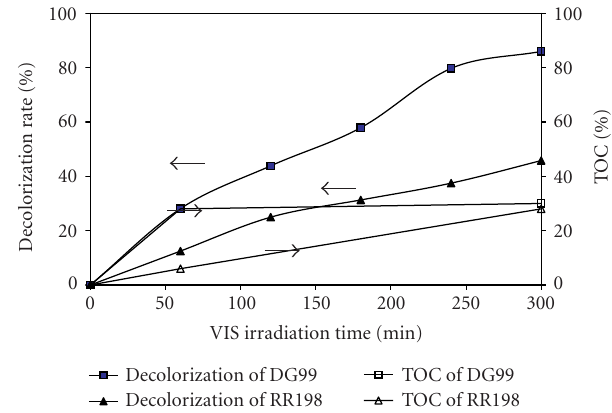
Figure 5: Decolorization and change of TOC of an aqueous solution of DG 99 and RR198 on TiO 2 /N 500 as a function of time of irradiation with visible